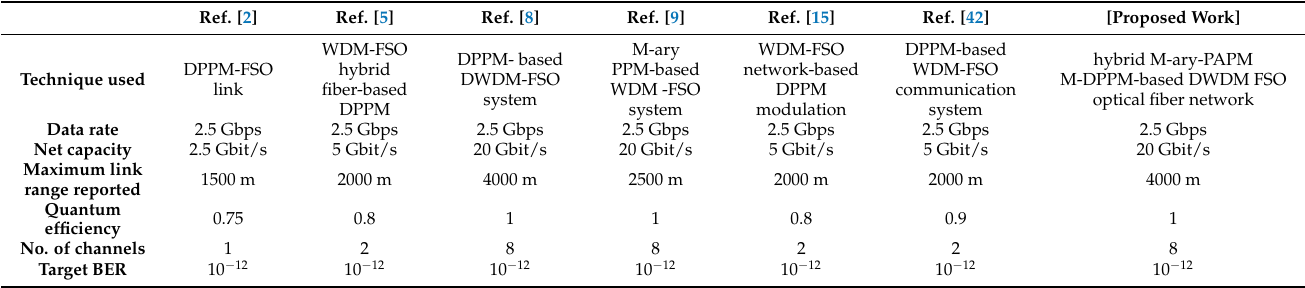
Figure 10. BER vs. AOP at RCL input (dBm) for DPPM and OOK for no turbulence and WT with all apertures averaging (AA). Table 3. Performance comparison of the proposed M-ary DPPM-M-PAPM based-DWDM-FSO optical fiber link with contemporary literature.